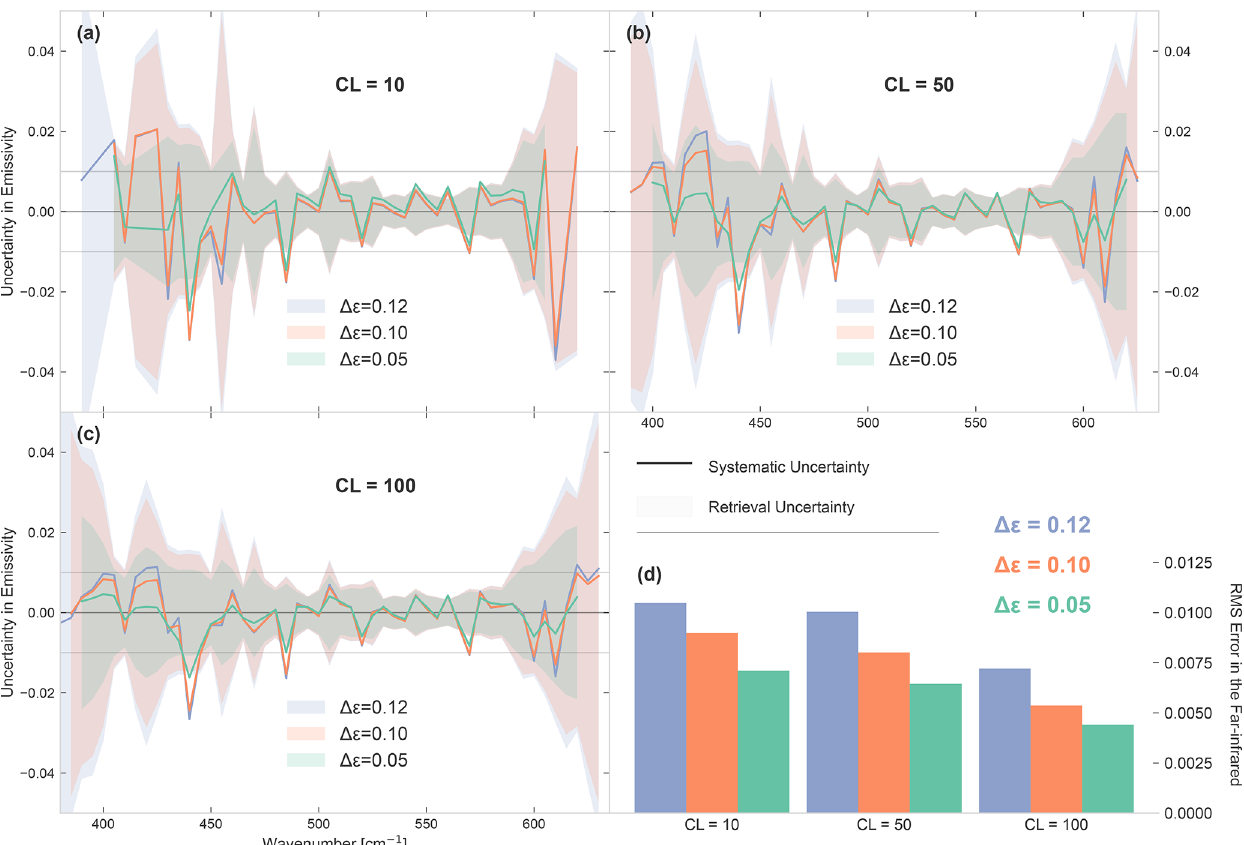
Figure B1. Systematic uncertainty in emissivity for different emissivity a priori uncertainty parameters in the far infrared. All nine retrievals are for the same fine snow emissivity at 67 ◦ N, 18 ◦ E on 15 January 2018 at 12:00:00UTC, with the default parameters as outlined in Sect. 3. Panels (a) , (b) and (c) show the uncertainties for retrievals with a correlation length (CL) of 10, 50 and 100, respectively. Each figure shows the systematic uncertainty (true minus retrieved emissivity) as a solid line for three values of the emissivity a priori uncertainty (cid:49)(cid:15) . The colours are green, orange and blue for (cid:49)(cid:15) values of 0.05, 0.1 and 0.12, respectively. The retrieval uncertainty 1 σ range for the respective retrievals is shown as a shaded region of the same colour. The uncertainties are shown only in the regions where the information quantifier for the respective retrievals is larger than 1 (not the same for each retrieval) between 350 and 650cm − 1 . Panel (d) shows the root mean square (RMS) error of the systematic uncertainty in the plotted spectral range for the nine